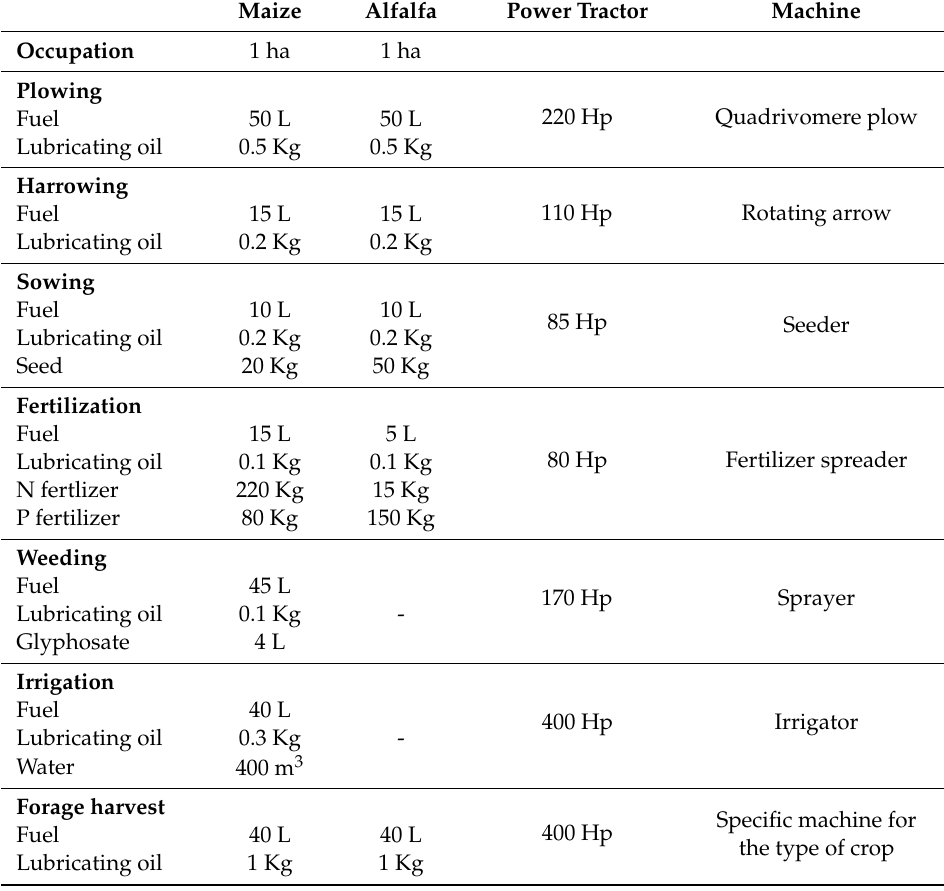
Table 2. Input material